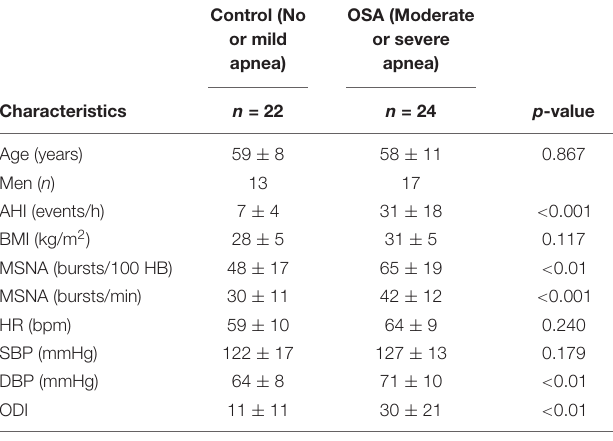
TABLE 1 | Participant characteristics.